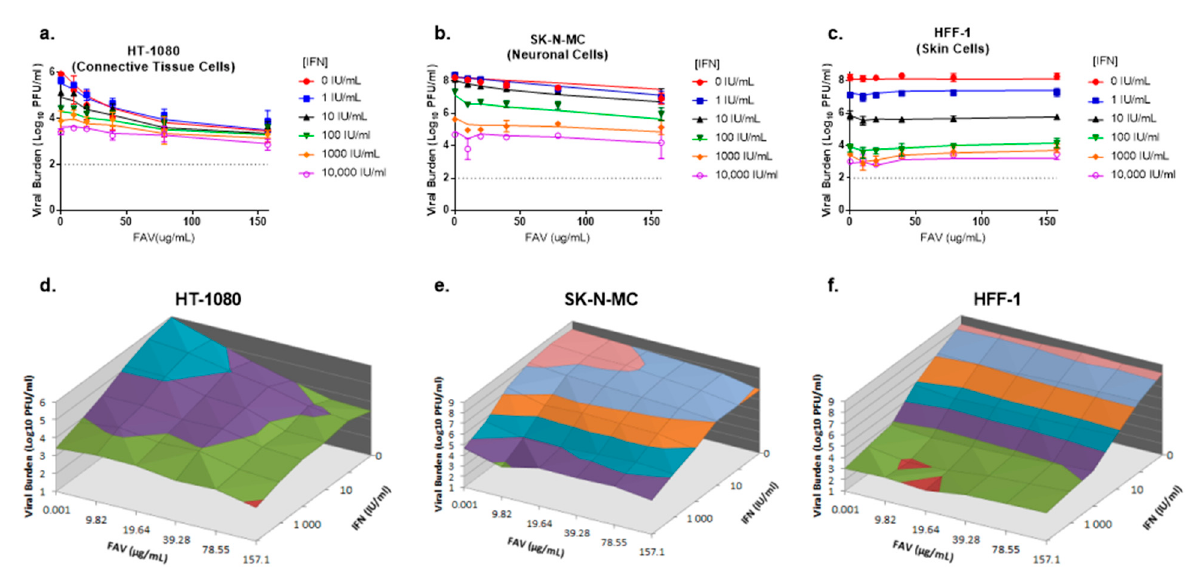
Figure 2. Antiviral activity of favipiravir (FAV) and interferon (IFN) combination therapy against CHIKV in HT-1080, SK-N-MC, and HFF-1 cells ( a – c ). HT-1080 ( a ), SK-N-MC ( b ), and HFF-1 ( c ) cells were infected with CHIKV at MOIs of 0.1, 0.01, and 0.001, respectively. Different concentrations of FAV, IFN or both were added to cells following infection. Day 2 viral burden was quantified via plaque assay on Vero cells. Data points represent the mean of three independent samples and error bars correspond to one standard deviation. Lines through the data points signify the predicted viral burden as determined by the mathematical model. The dashed line signifies the assay limit of detection. ( d – f ) Three-dimensional plots illustrating viral burden for FAV + IFN combination regimens on HT-1080 ( d ), SK-N-MC ( e ), and HFF-1 ( f ) cells are shown.